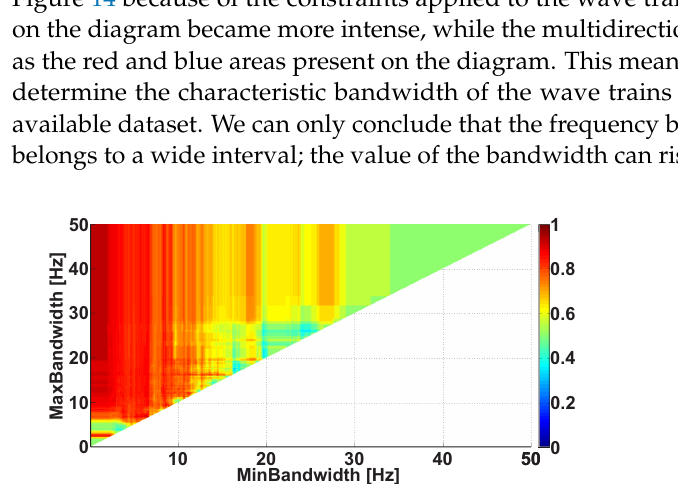
Figure 17. An example of the Bandwidth AUC diagram. The following constraints are applied to the wave train parameters: a frequency from 8 to 20 Hz and a PSD no less than 30 µ V 2 / Hz. The abscissa axis indicates the lower bound of the bandwidth; the ordinate axis indicates the upper bound of the bandwidth. The diagram demonstrates multidirectional